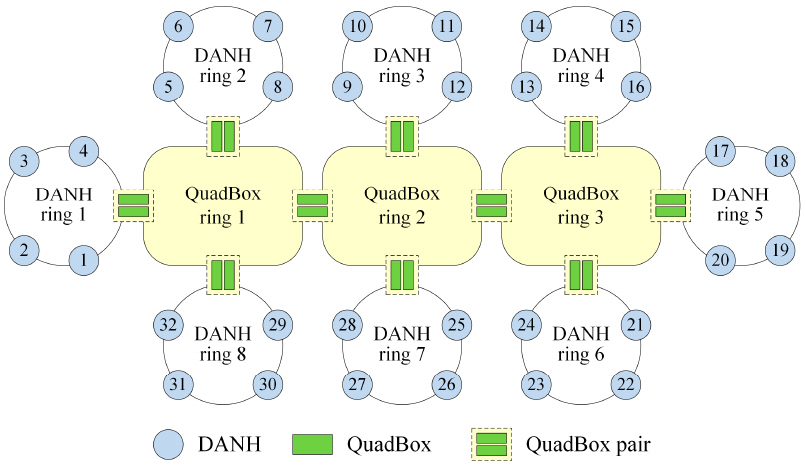
Figure 1. A high-availability seamless redundancy (HSR) network with eight doubly-attached node with HSR protocol (DANH) rings.